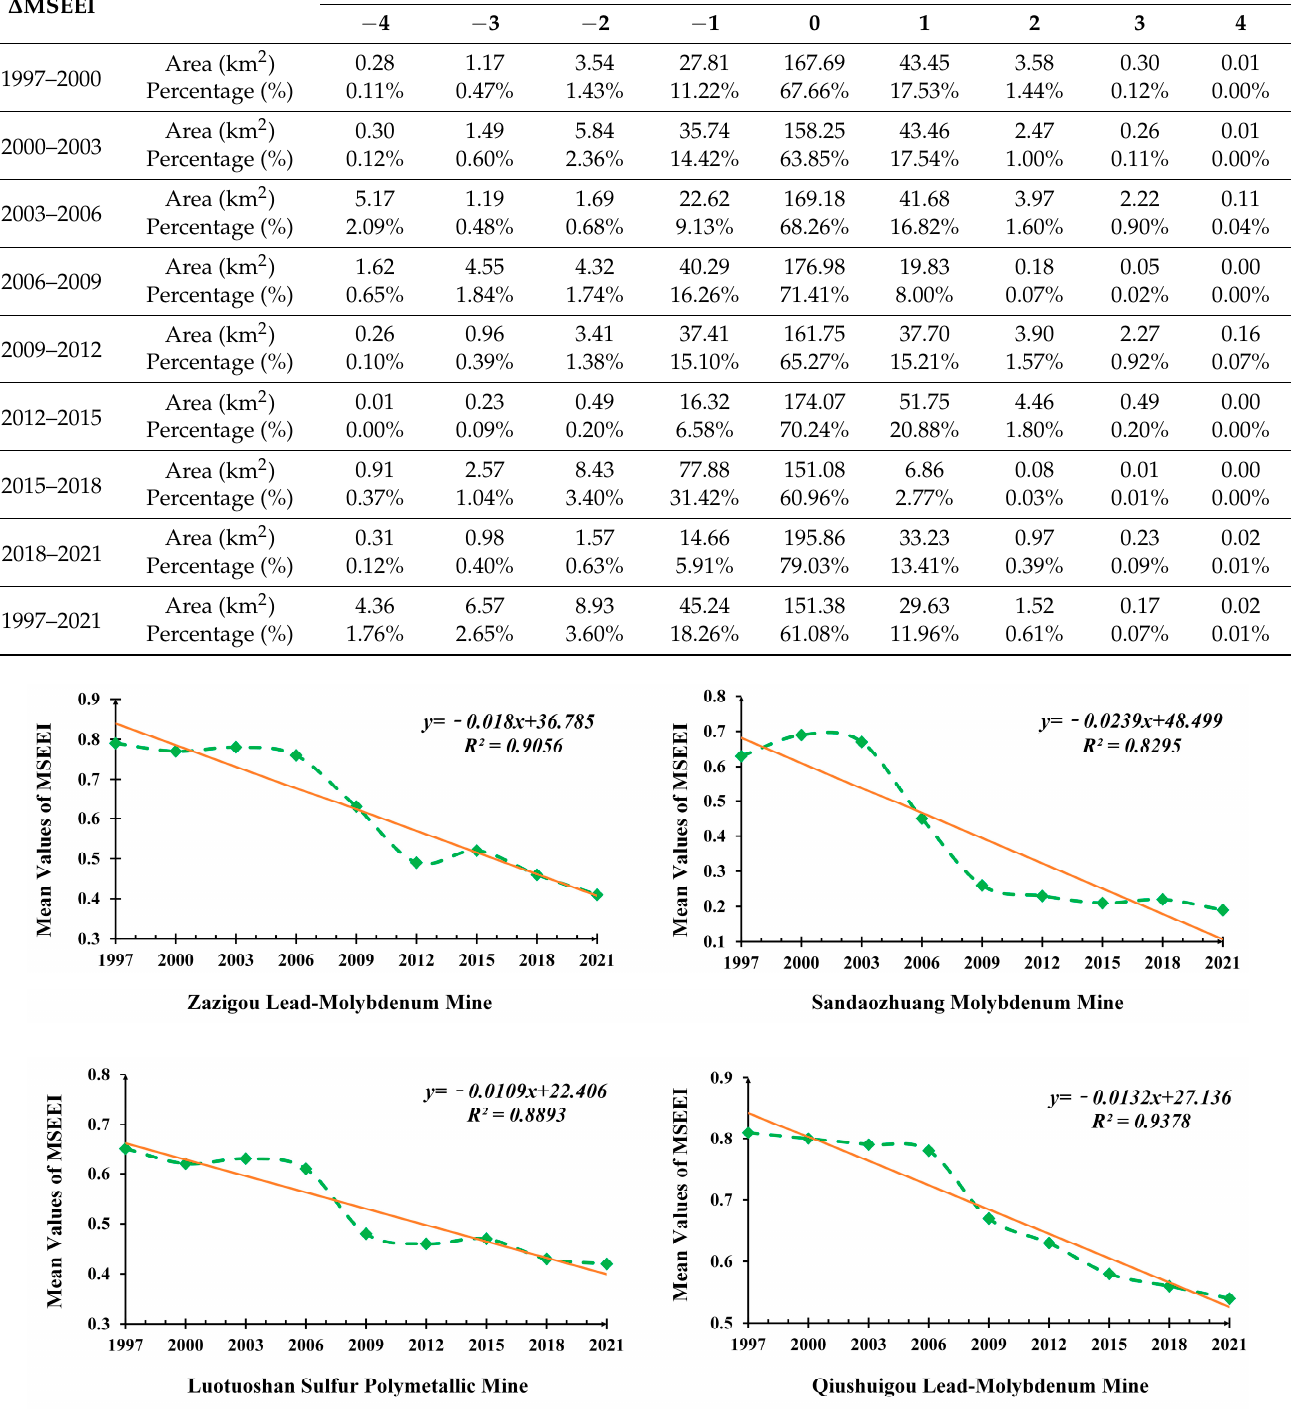
Figure 9. Mean values of the MSEEI for selected mining scopes in 1997, 2000, 2003, 2006, 2009, 2012, 2015, 2018, and 2021. Table 3. MSEEI values in each grade percentage of mining scopes.